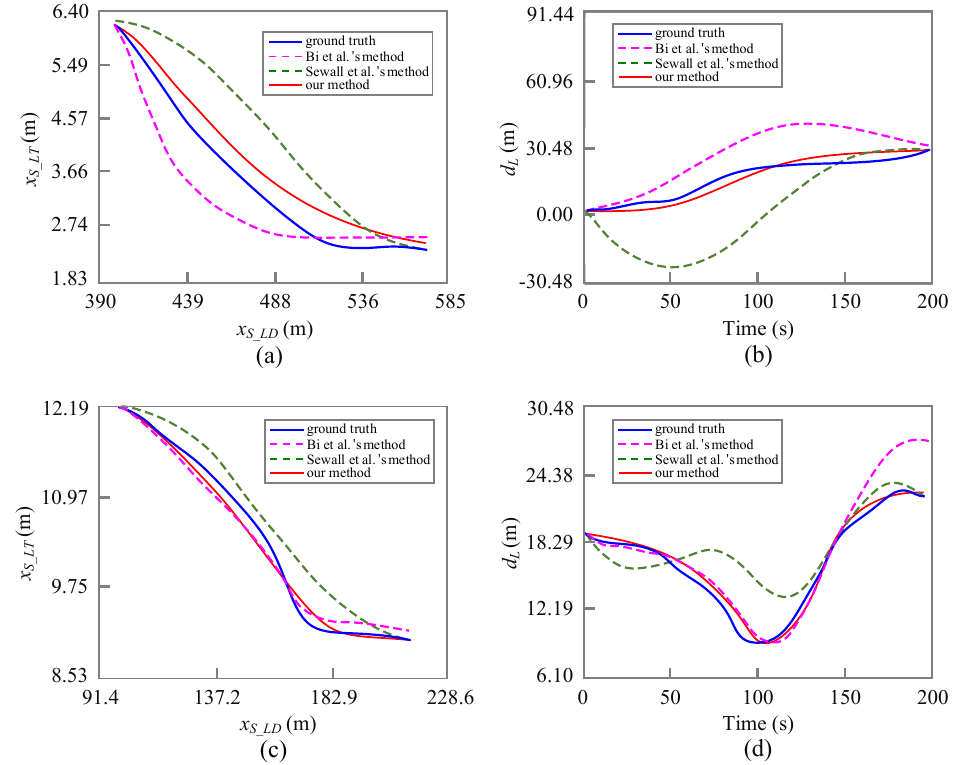
Figure 5. Position comparison of different methods. ( a , c ) respectively denote trajectories of V2719 and V2823. ( b , d ) respectively denote the gaps to the leader for V2719 and V2823.